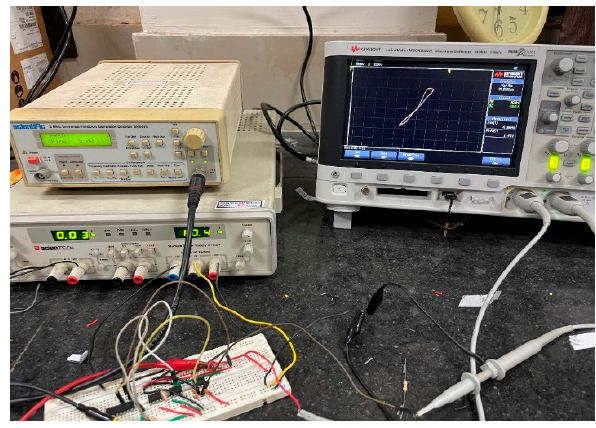
Figure 18. Complete experimental setup of the proposed memristor.